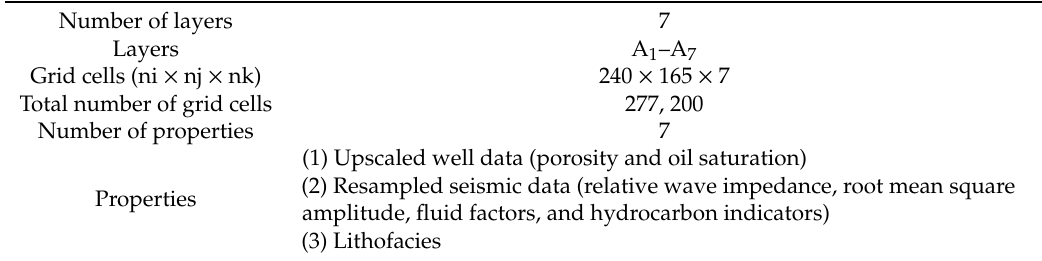
Table 2. Grid model parameters of the study area.